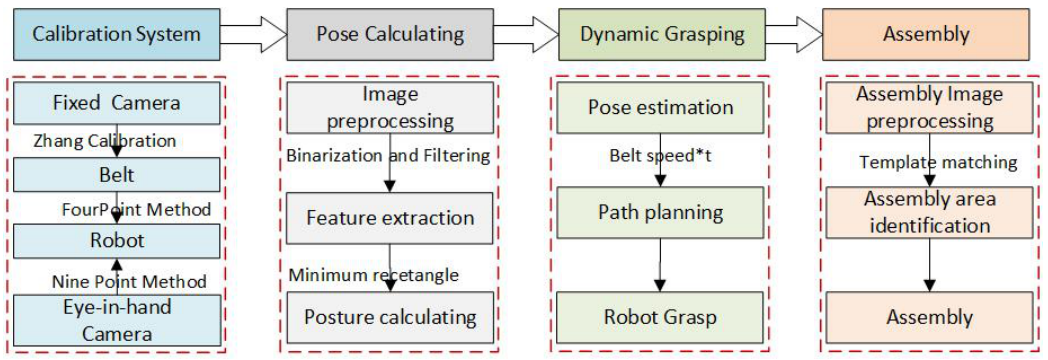
Figure 4. Assembly production of phone shell.